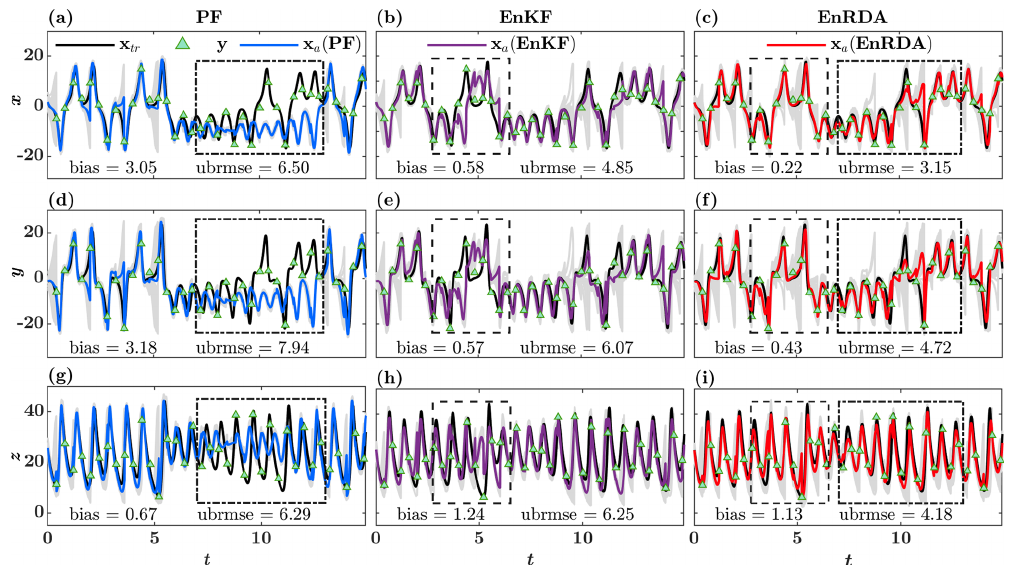
Figure 6. Temporal evolution of the true state x tr in Lorenz-63, observations y , and the analysis state x a for the particle filter (PF) (a, d, g) , ensemble Kalman filter (EnKF) (b, e, h) , and ensemble Riemannian data assimilation (EnRDA) (c, f, i) , with 100 particles (ensemble members). The temporal evolution of the particles and ensemble members are shown with solid gray lines. Also shown within dashed boxes are the windows of time over which the DA methods exhibit large errors.